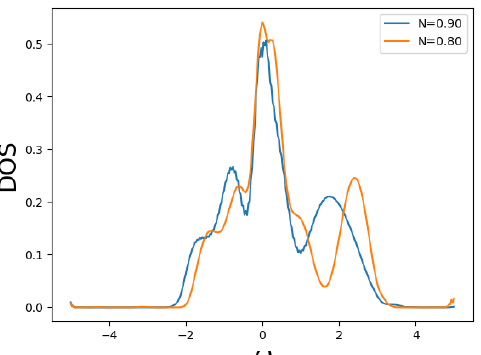
Figure 6. Spectra of the model at T = 0.025 for N = 0.80 and N = 0.90. The density of states peak around zero